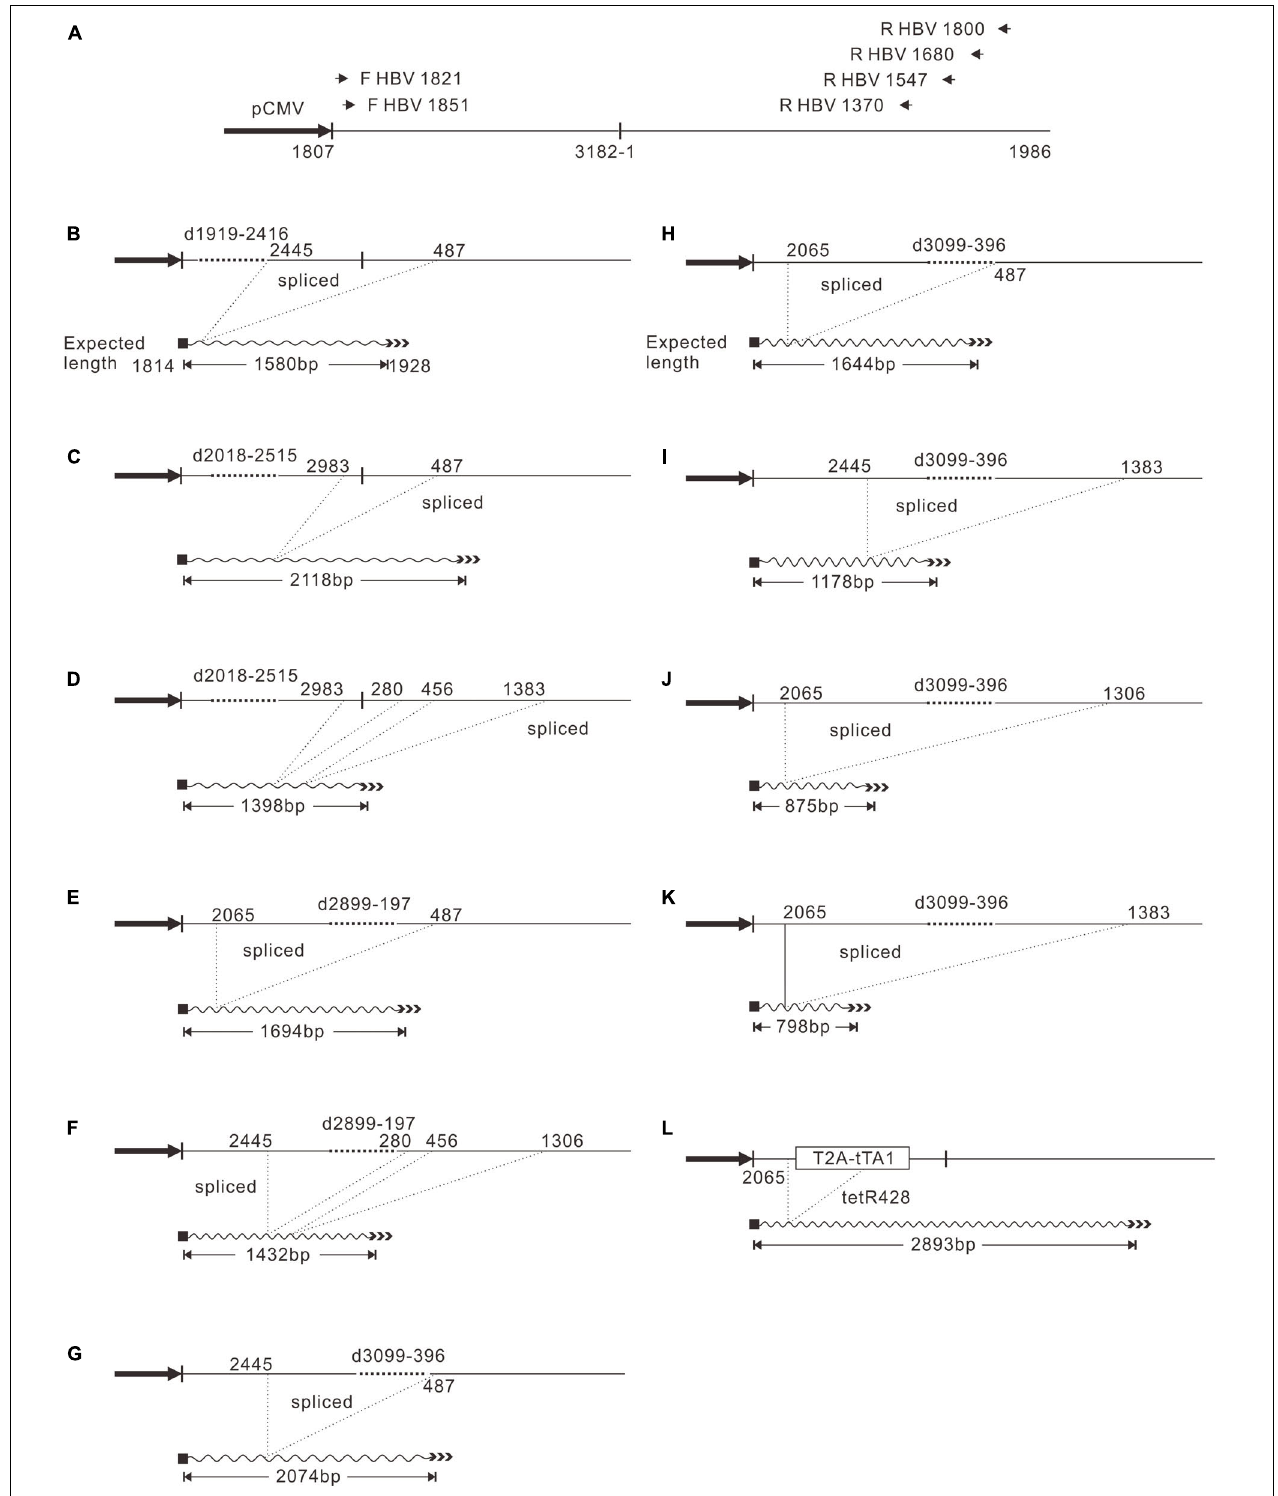
FIGURE 4 | PgRNA splicing pattern of D1919-2416, D2018-2515, D2899-197, D3099-396, and 2120-T2A-tTA1-2820. (A) Primers used for reverse transcription and PCR. Each primer was named by the position of 5 (cid:48) end, respectively. PgRNA was reverse transcribed with reverse primers and subjected to PCR amplification using each forward primer combined with each reverse primer. The shortest bands were gel-purified and sequenced. (B) PgRNA splicing of D1919-2416. (C,D) PgRNA splicing of D2018-2515. (E,F) PgRNA splicing of D2899-197. (G–K) PgRNA splicing of D3099-396. (L) PgRNA splicing of 2120-T2A-tTA1-2820.